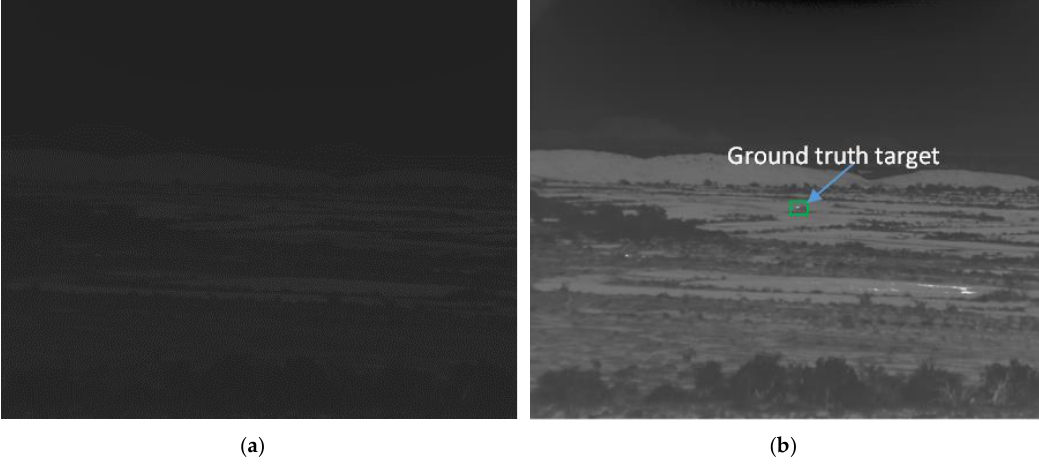
Figure A2. Before and after comparison of applying Approach 1. ( a ) Raw image; ( b ) Contrast-enhanced